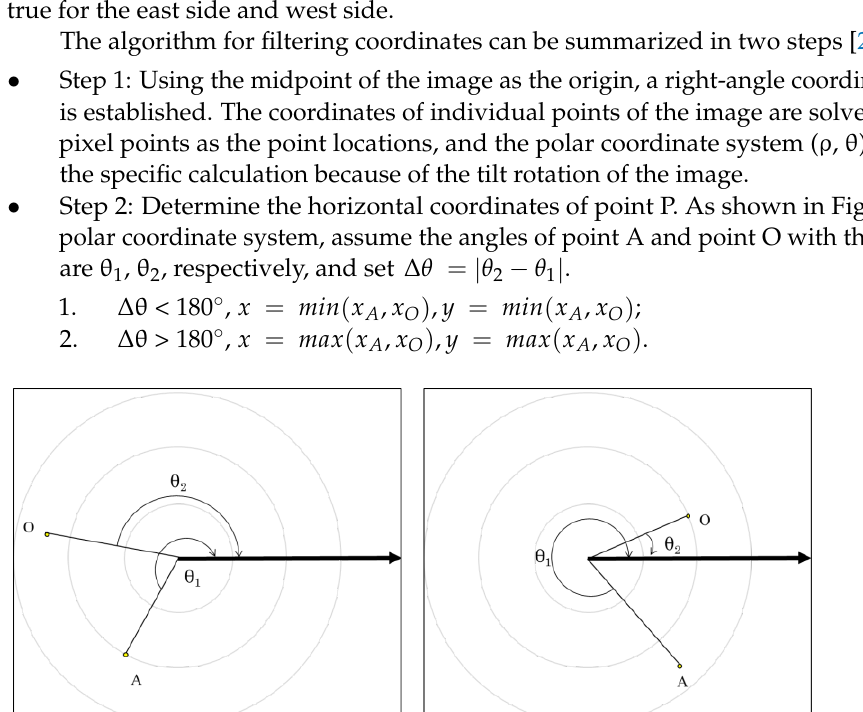
10 of 17 Figure 10. Schematic diagram of the pseudo-twin light positioning algorithm. If the measured distance is less than the true distance, this will lead to no solution to the system of equations, and the coordinates of point P can be approximated as the midpoint of A and O. In the normal case, the equation has roots, then the two projected